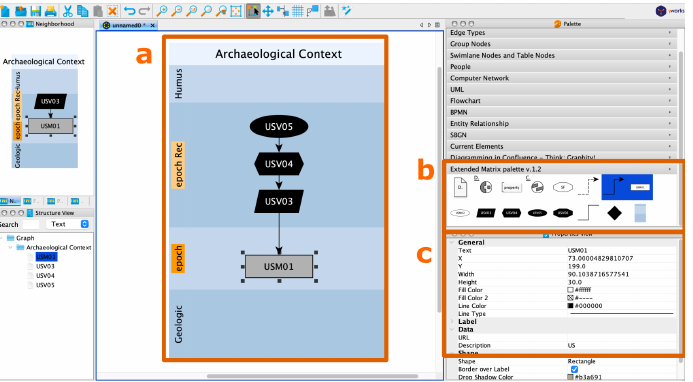
Figure 17. yEd graph editor to create Extended Matrices ( a ) with a custom EM palette ( b ) with the nodes of the formal language. Once selected a node, its name, url and description can be edited ( c ).